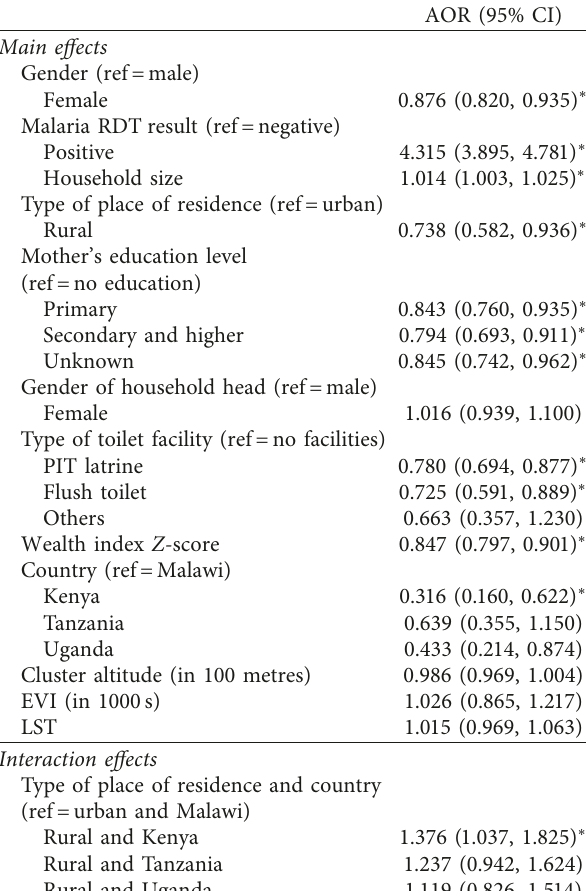
Table 1: Adjusted odds ratio estimates (AOR) and 95% confidence intervals (CI) for the fixed effects.